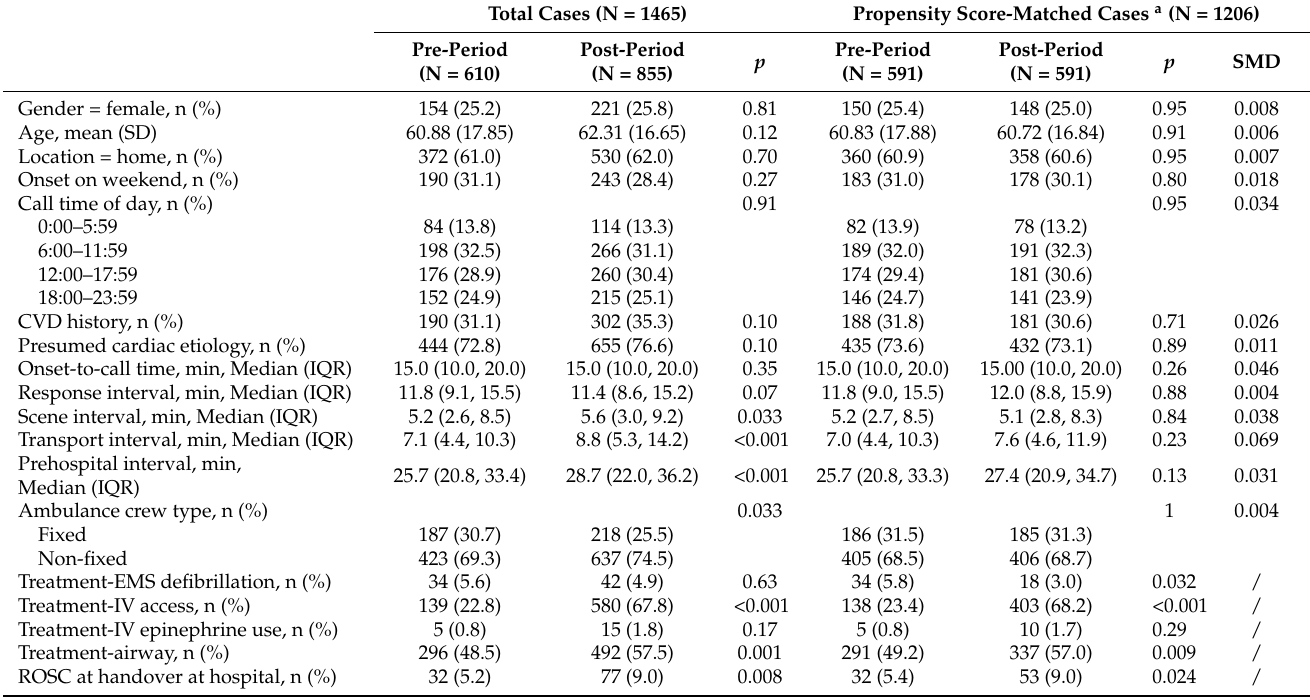
Table 1. Demographics, prognostic factors, and outcomes of OHCA patients during the pre-period and post-period in total cases and propensity score matched